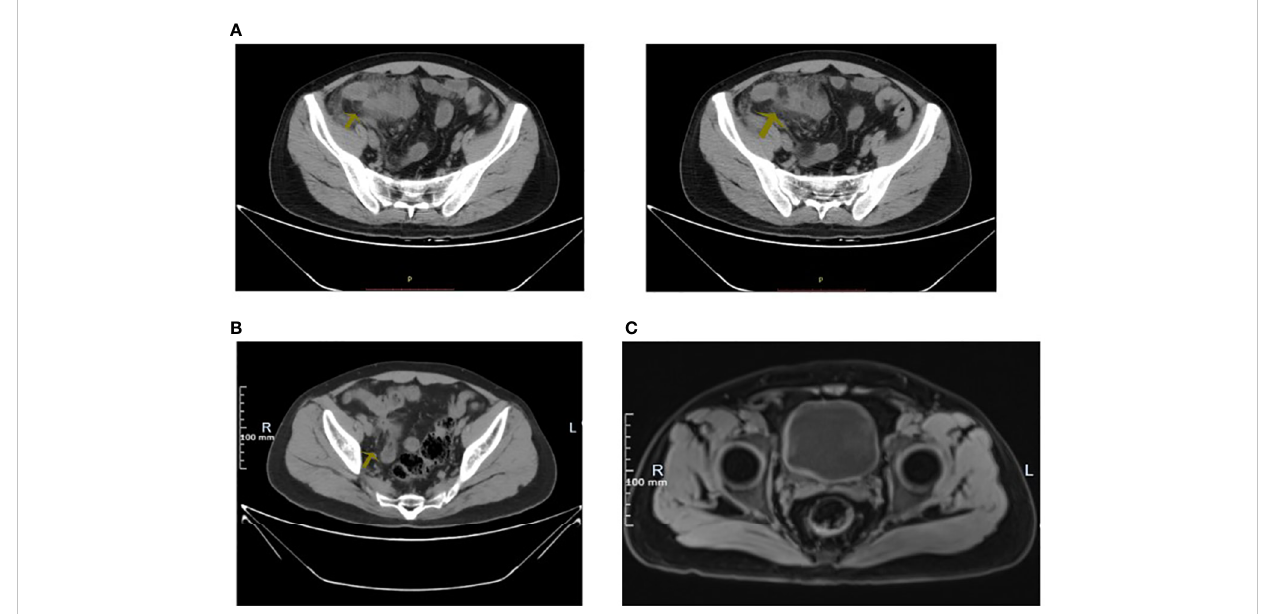
FIGURE 2 (A) Hypogastrium CT in July 2021: The arrow displayed that there was unclear appendix, the cloudy surrounding fat space, and a little free gas. (B) Hypogastrium CT in November 2022: The arrow displayed that there was slightly entangled intestine with the blurred surrounding fat space in the right pelvic cavity. (C) MRI: The arrow displayed that the bladder fi lled